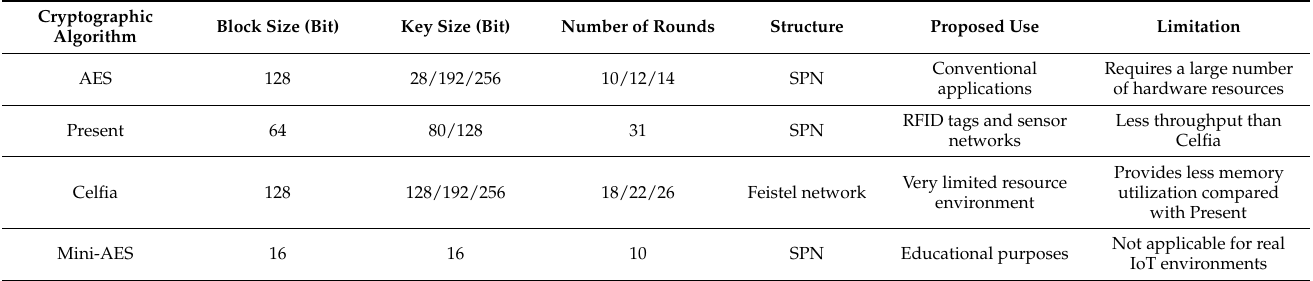
Table 2. Comparison between cryptographic